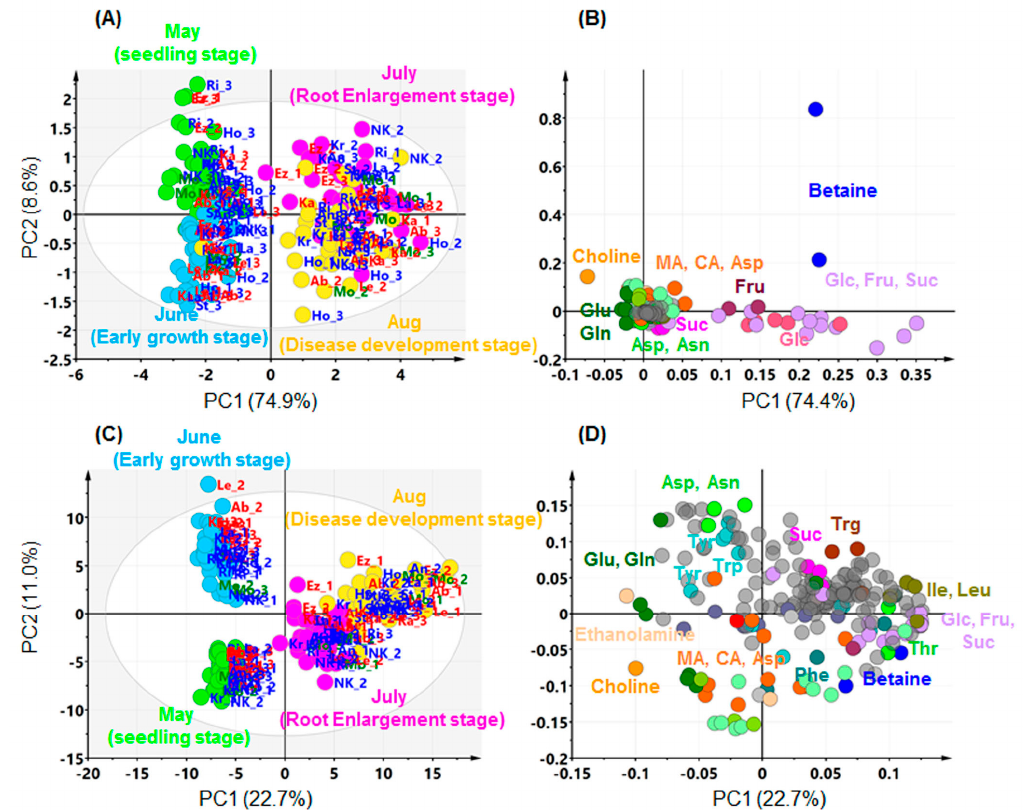
Figure 2. Principal component analysis (PCA) score ( A , C ) and loading ( B , D ) plots of the NMR data of sugar beet leaves. Pareto ( A , B ) or unit variance ( C , D ) scaling was applied to the NMR buckets. The abbreviations of genotypes harbouring weak (red), moderate (green), and strong (blue) resistance levels are defined in Table 1. Grey circles in the loading plots indicate unannotated NMR buckets.